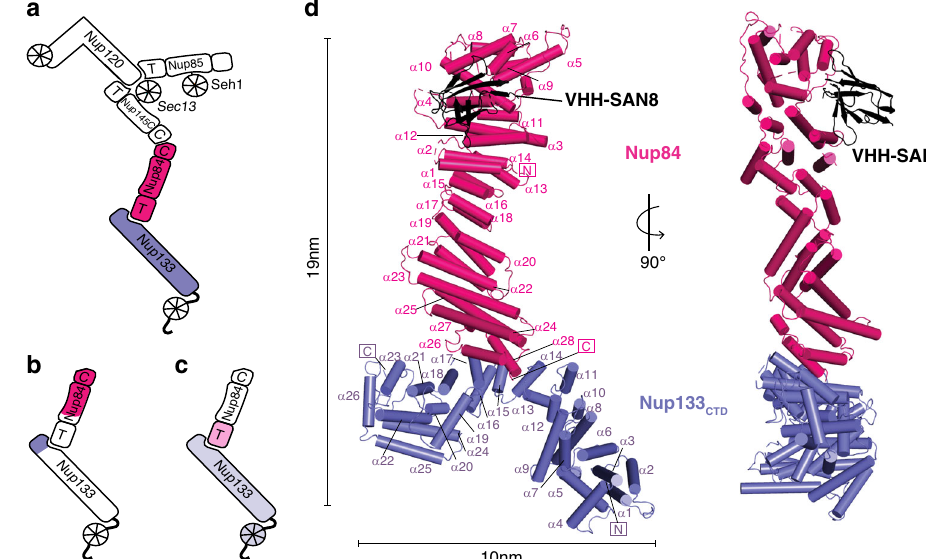
Fig. 1 Structure of the Saccharomyces cerevisiae Nup84-Nup133 CTD -VHH-SAN8 complex. a Schematic of the S. cerevisiae Y complex. Regions included in the structure are colored (Pink — Nup84, Purple — Nup133). Elements of ACE1 fold proteins are indicated: T — tail and C — crown adjacent to the central trunk element. b Schematic of S. cerevisiae Nup84-Nup133 with previously solved fragments colored as in a . c Schematic of homologous human Nup107-Nup133 with previously solved fragments colored in light pink — Nup107 and light purple — Nup133. d Structure of Nup84-Nup133 CTD -VHH-SAN8, with Nup84 in pink, Nup133 CTD in purple, and VHH-SAN8 in black. N and C termini are indicated and helices are numbered. Right panel shows the side view (90° rotation) of the